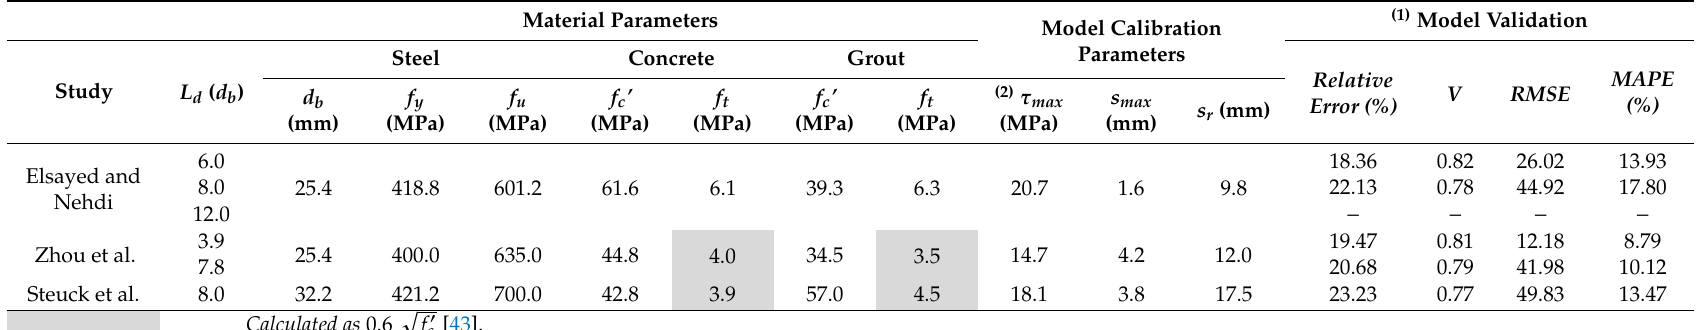
Table 1. Material parameters for concrete, steel, and grout, bond–slip model calibration parameters, and model